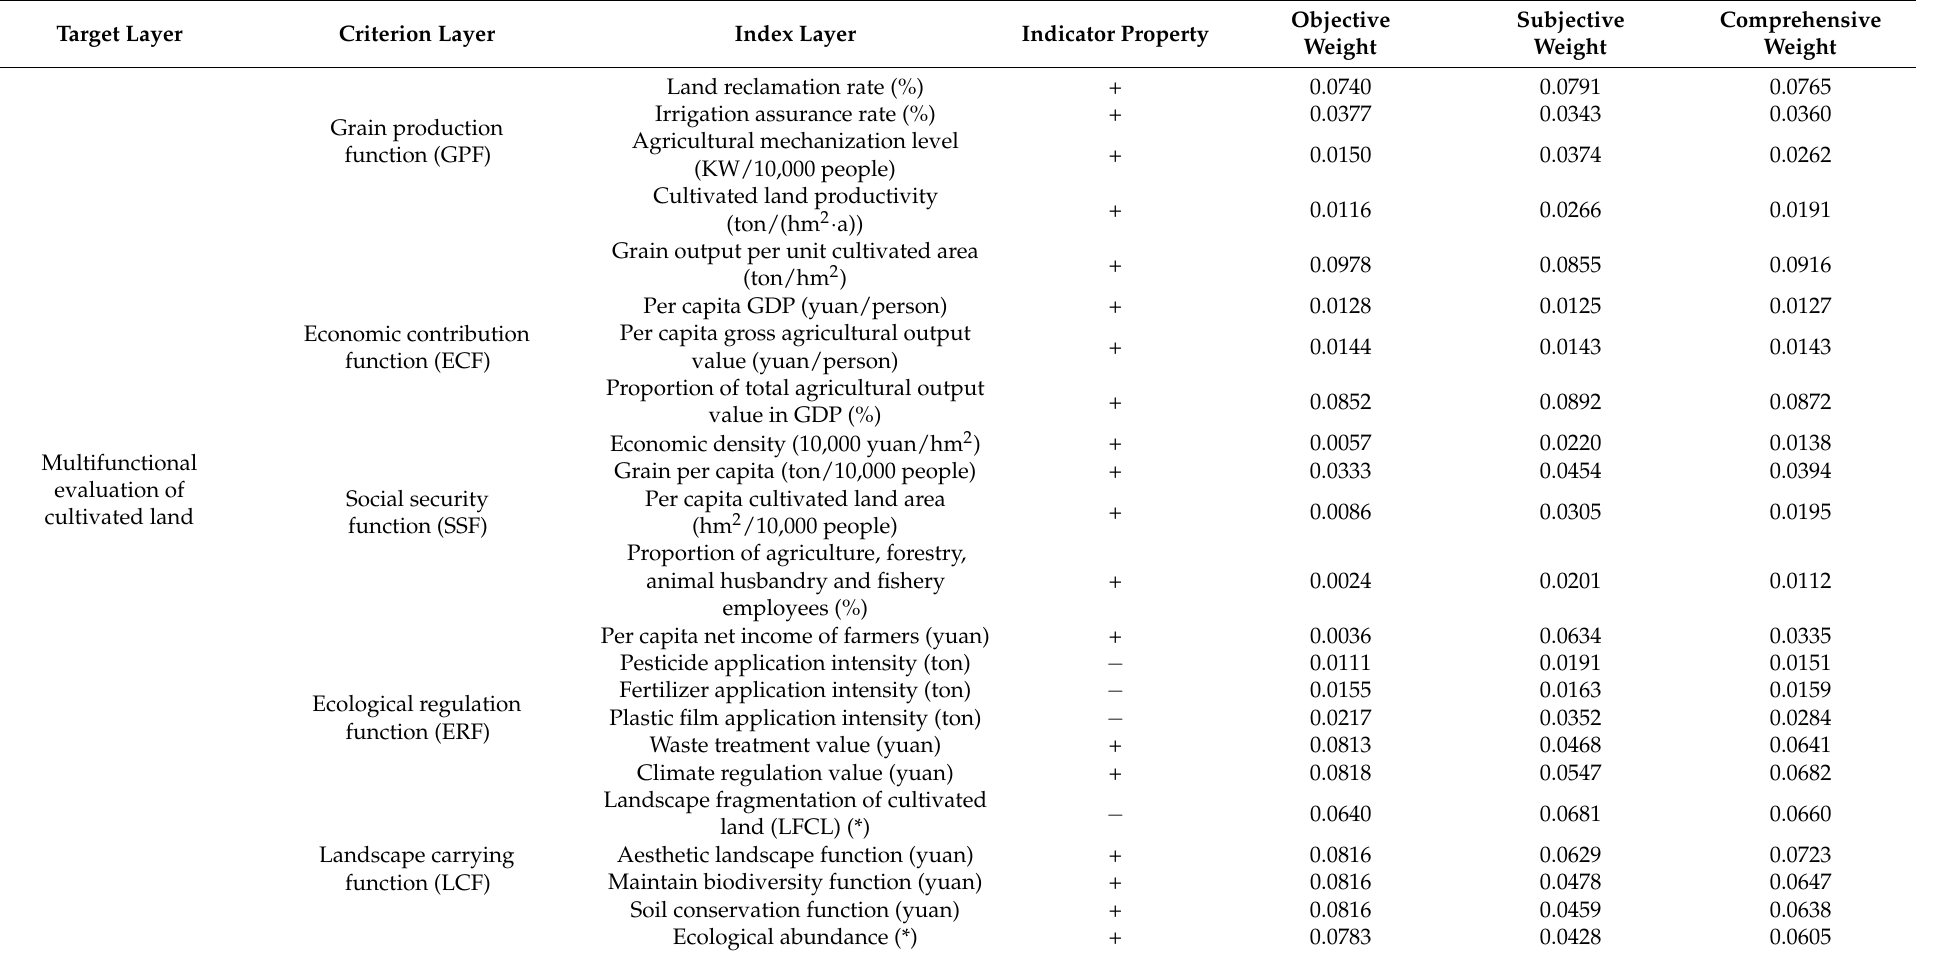
Table 2. Multifunctional evaluation index system of cultivated land in the two lake